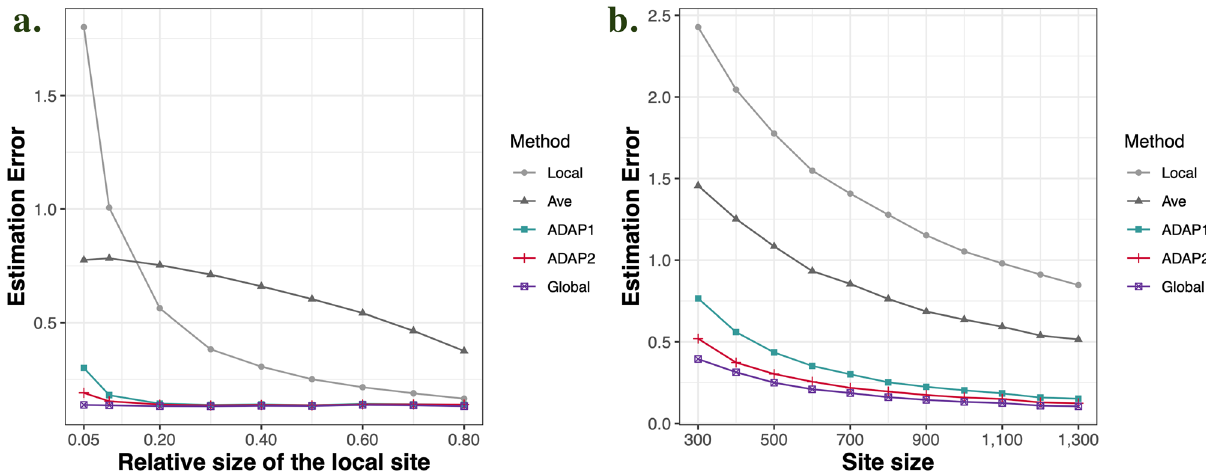
Figure 2. Simulation results under Setting 3 and Setting 4. The panel ( a ) is for Setting 3, which shows the change of estimation error averaged over 200 replications along with an increasing local sample size n 1 . The total sample size N is fixed at 10,000. The panel ( b ) is for Setting 4 where all sites share the same sample size n and the number of sites K is fixed at 10. The plot shows the change of estimation error averaged over 200 replications along with an increasing n (i.e., an increasing N ). Magnitude ( β j )